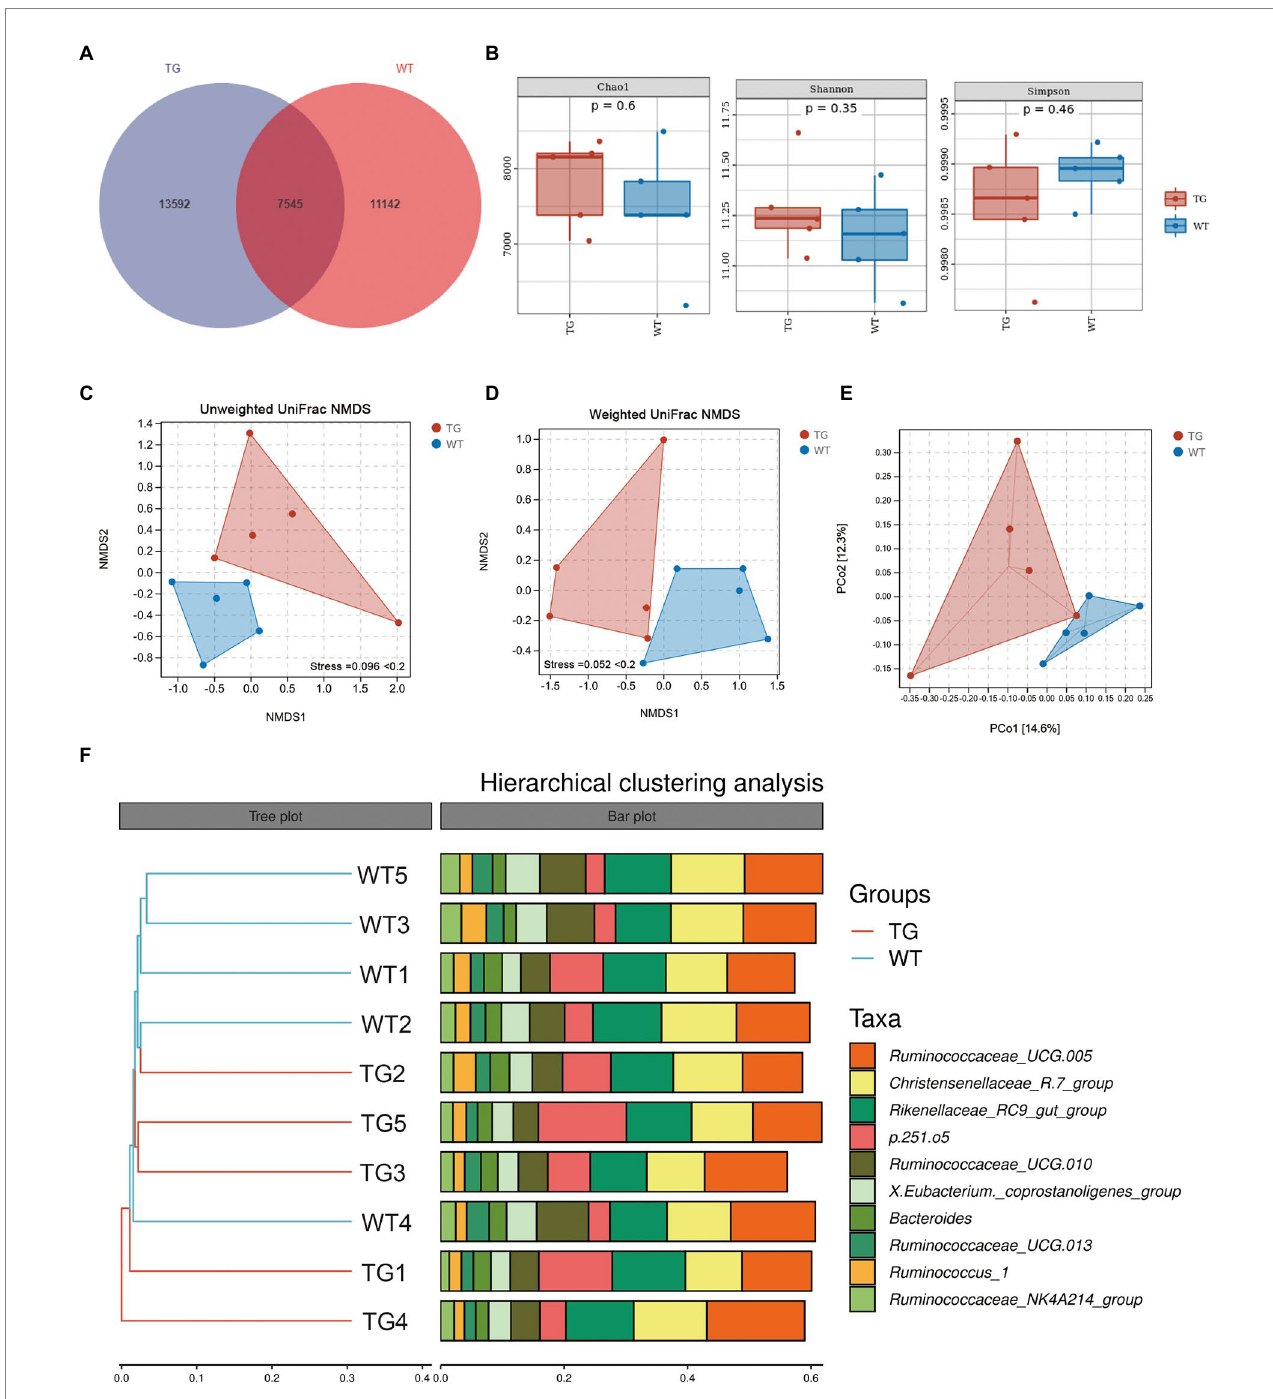
FIGURE 3 Effects of TLR4 on gut microbiota richness and diversity. (A) The venn diagram displayed the overlapping core microbiota of TG group and WT group. (B) Alpha diversity analysis was performed by Chao1 index, Shannon index and Simpson index. (C) NMDS analysis based on unweighted UniFrac distances. (D) NMDS analysis based on weighted UniFrac distances. Each point in the graph represents an individual and the shorter distance between the points, the more similar microbial community structure between individuals. (E) PCoA score plots of ASVs between TG and WT groups. Principal components (PCs) 1 and 2 explain 14.6% and 12.3% of the variance, respectively. The location and distance of the data points indicate the presence of bacterial taxa and the degree of similarity in relative abundance. (F) Hierarchical clustering analysis of ASVs by UPGMA in TG and WT groups. TG1-5: five TLR4 overexpressing sheep, WT1-5: five WT